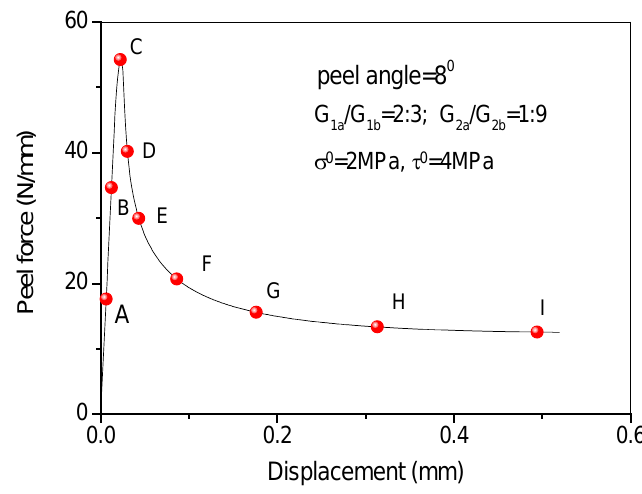
Figure 16. Load-displacement curve when peel angle = 8 degree.